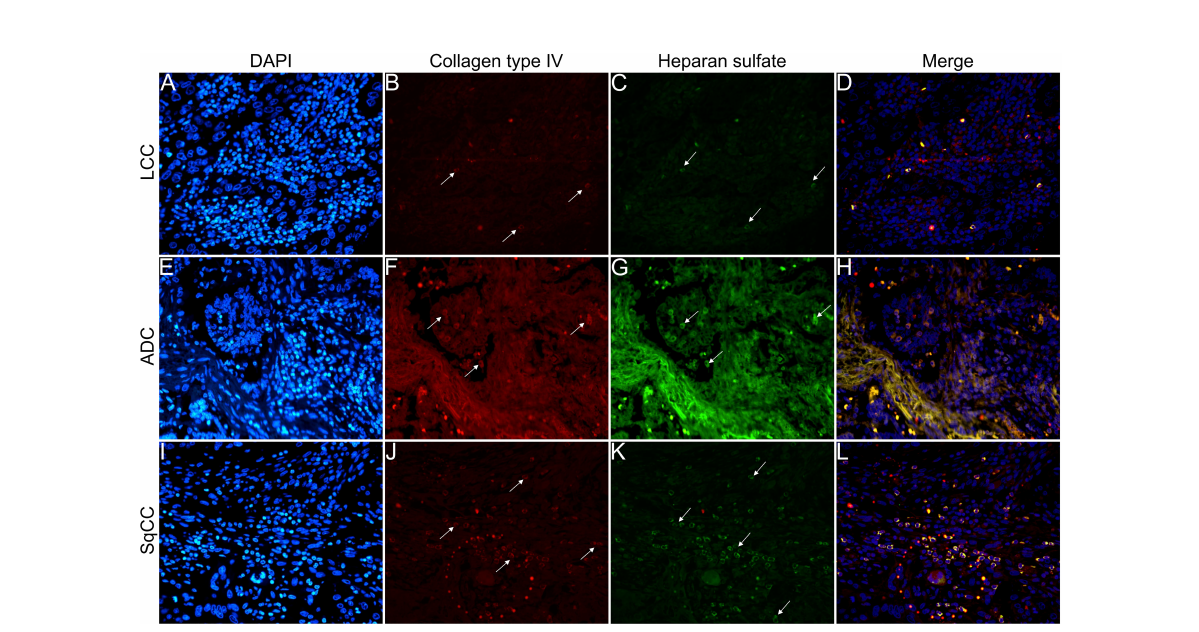
FIGURE 8 Co-analysis of immuno fl uorescence of heparan sulfate (green; C , G , K ) and collagen type IV (red; B , F , J ) in three different histological subtypes of non-small cell lung carcinoma (N=120). The stained nuclei are represented in blue (DAPI; A , E , I ). Images D , H , L represent the merge of the same fi eld of these three stains. White arrows indicate positive expression of the markers. Original magni fi cation: 40x. LCC, large cell carcinoma; ADC, lung adenocarcinoma; SqCC: lung squamous cell carcinoma.